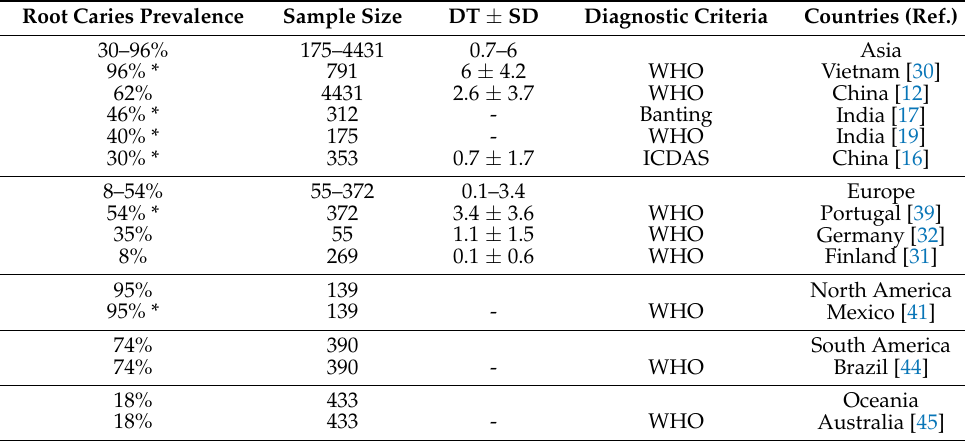
Table 4. Summary of the included studies reported on root caries.